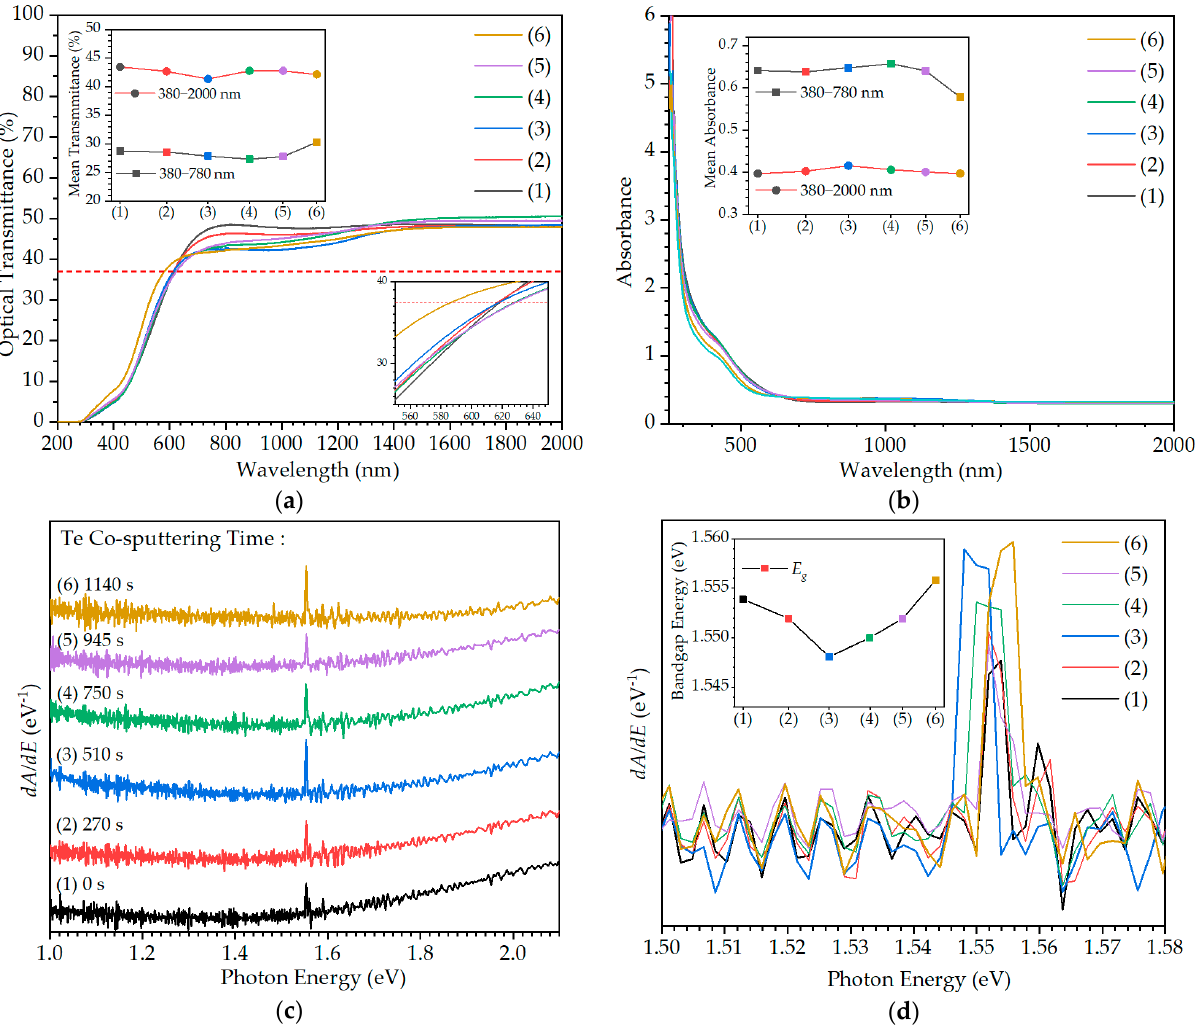
Figure 5. Optical properties of the CIGS:Te thin films with different Te co-sputtering times of (1) 0, (2) 270, (3) 510, (4) 750, (5) 945, and (6) 1140 s. ( a ) Optical transmittance. The inset shows the mean optical transmittance in the visible and near-infrared (NIR) spectral regions. Magnitude of the optical transmittance in the visible spectral region is also shown in the inset. ( b ) Absorption coefficient. Mean absorbance in the visible and NIR spectral regions is shown in the inset. ( c ) The first derivative of absorbance as a function of incident photon energy for determination of the band gap. ( d ) Magnitude of the first derivative of absorbance spectrum. The inset shows the estimated band gap.